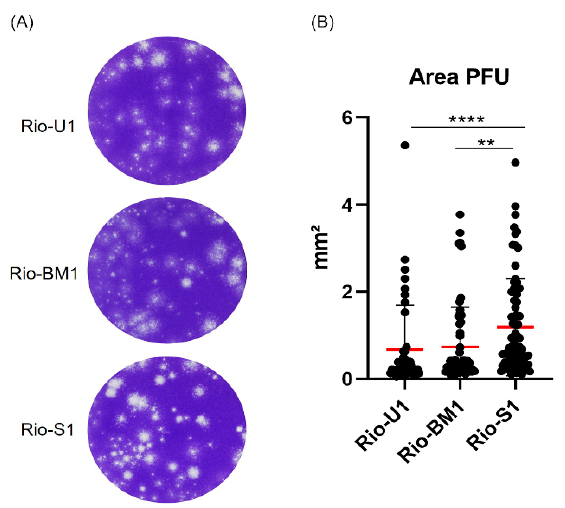
Figure 4. Plaque size phenotype of ZIKV isolates Rio-U1, Rio-BM1 e Rio-S1. ( A ) Infected Vero cell monolayer stained with crystal violet. ( B ) Scatter plot graphs indicating the individual values for plaque area. Red bars represent the median area. ** represents p ≤ 0.01, and **** represents p ≤ 0.0001.